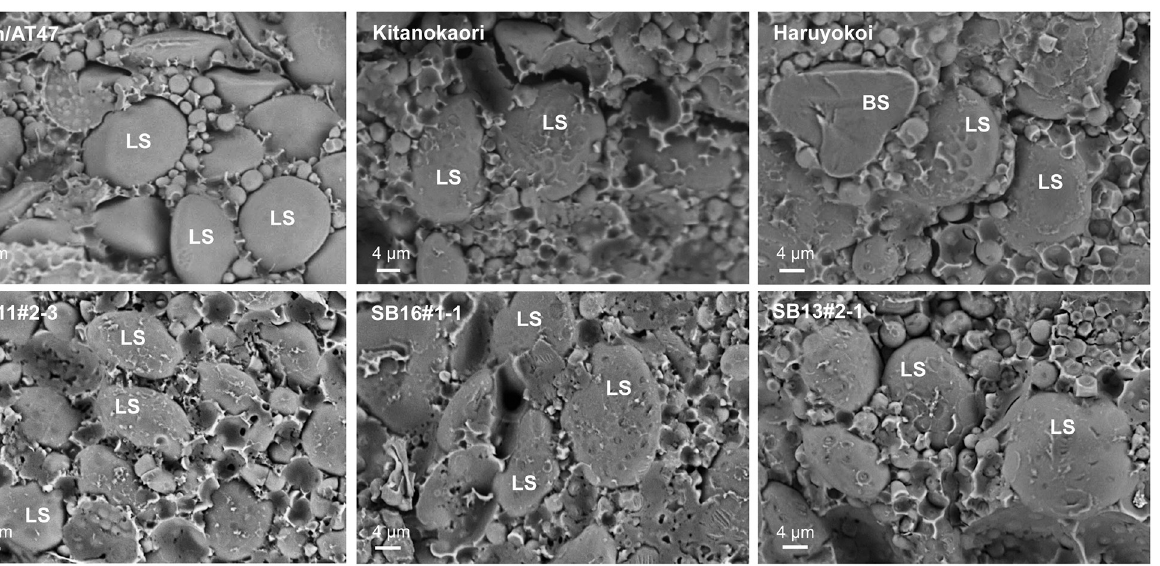
grain section phenotype of the selected lines was similar to that of the parental cultivars, indi- cating that the endosperm texture was hard in the selected lines.